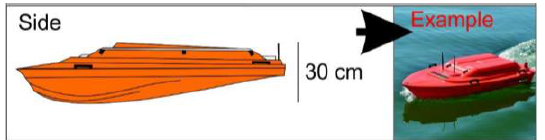
Figure 19. New design for water